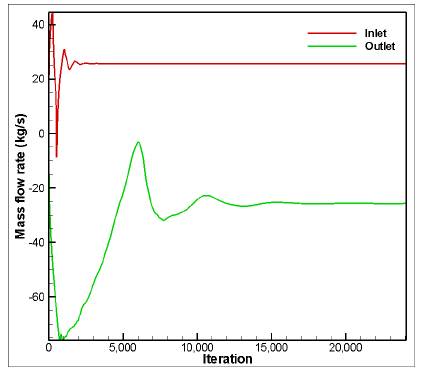
Figure 7. Time histories of mass flow rates.